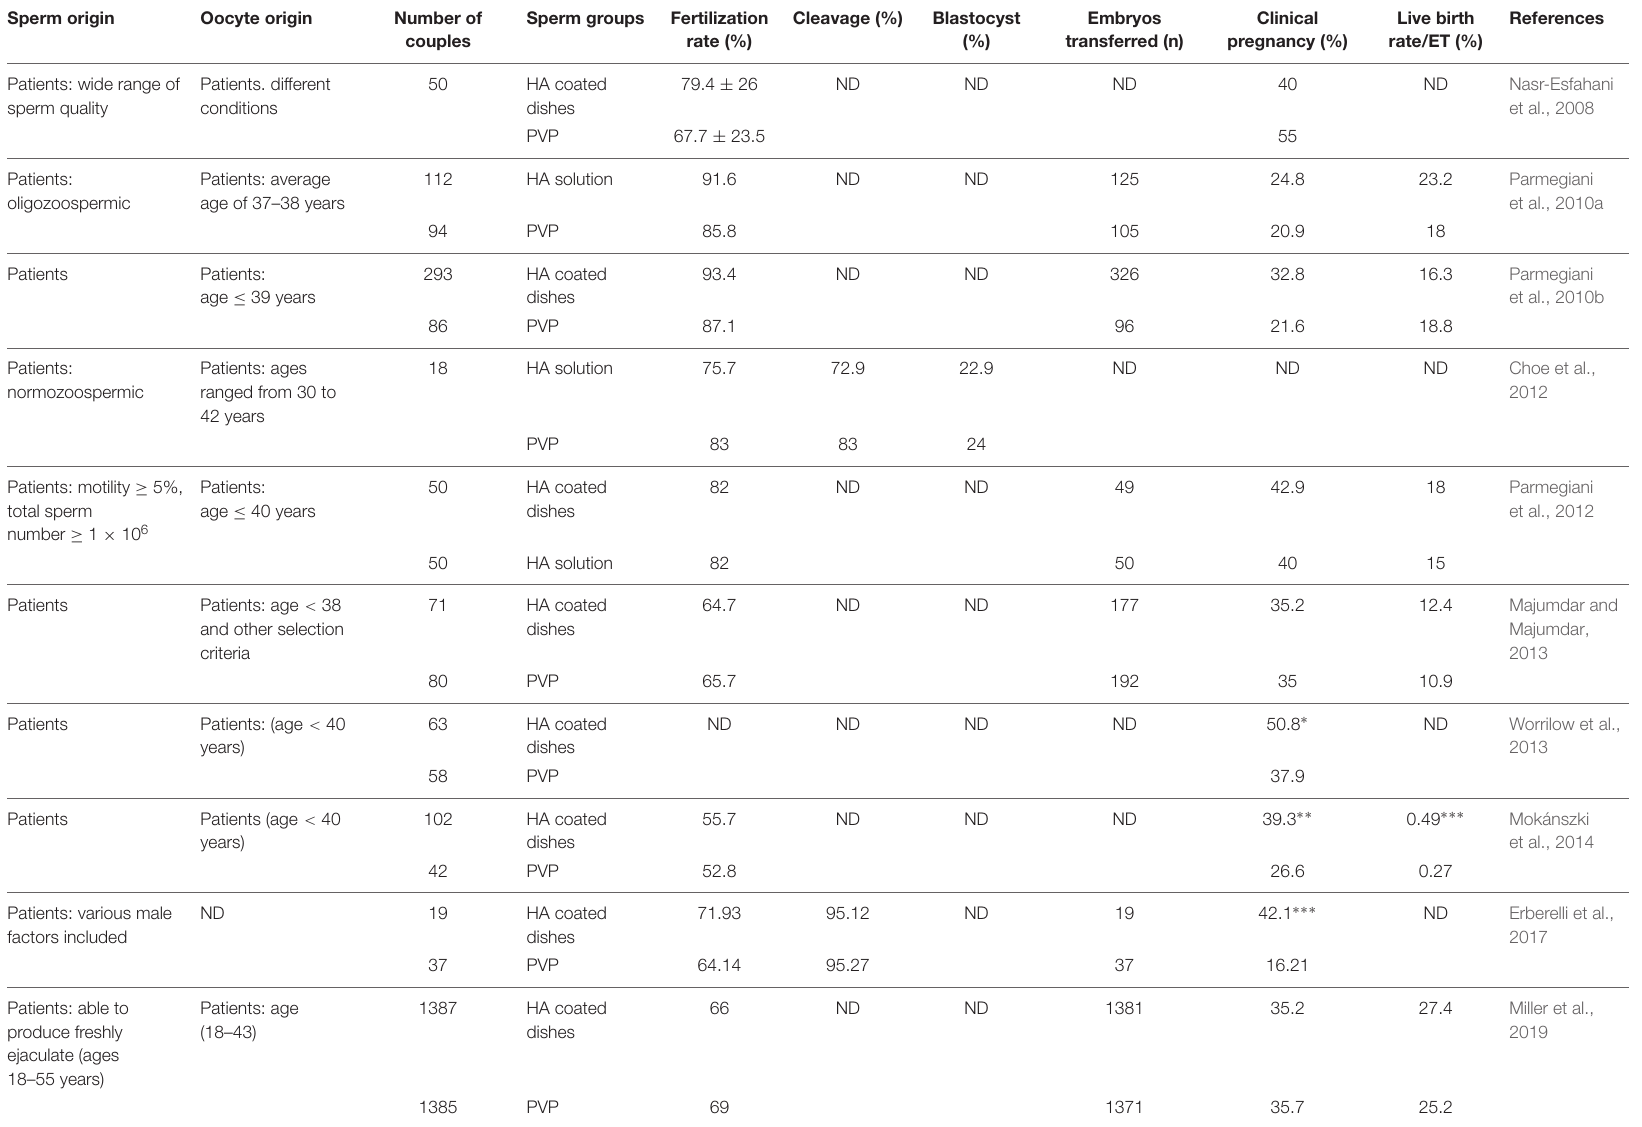
Sperm groups Fertilization Cleavage (%) Blastocyst Embryos Clinical Live birth couples rate (%) (%) transferred (n) pregnancy (%) rate/ET (%)